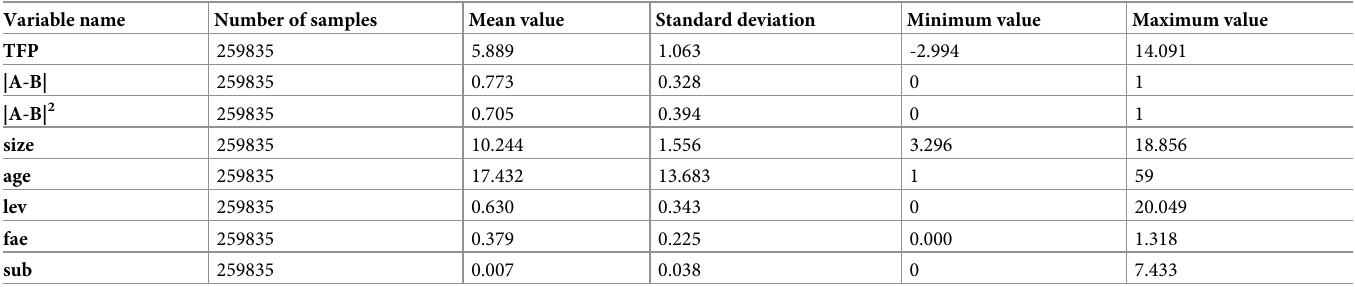
Table 2. Descriptive statistics of the main